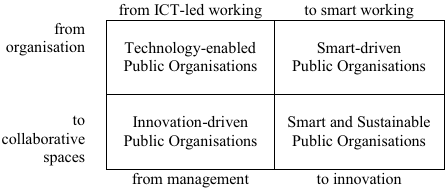
Fig. 1. Towards smart and sustainable public organisations